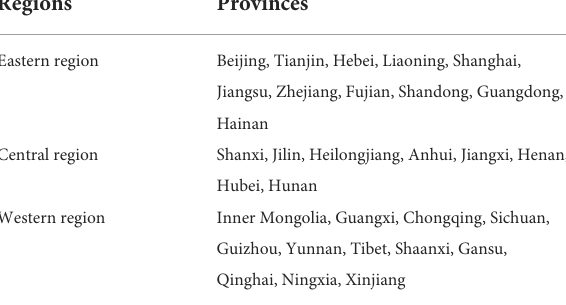
TABLE 3 China’s three main regions.